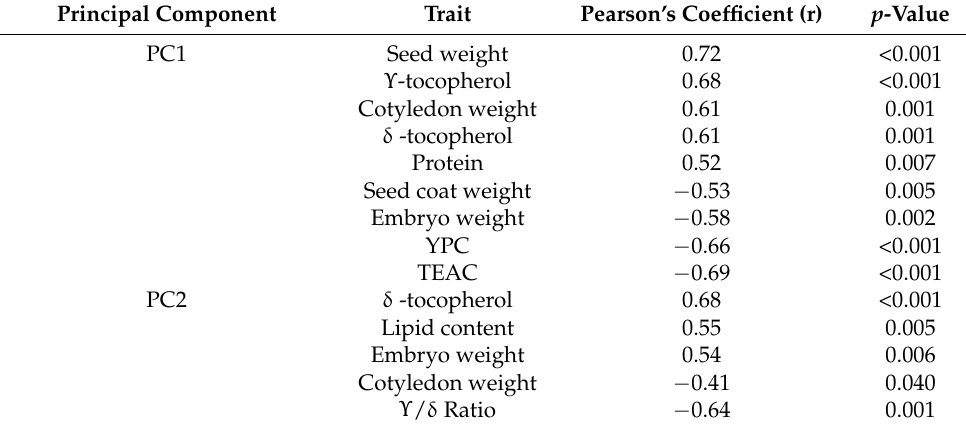
Table 6. Correlation coefficients between the principal components, PC1 and PC2, and seed mor- phological and compositional traits. Only significant correlations are shown ( p <